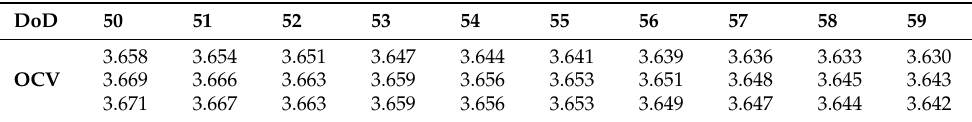
Table A6. OCV models parameters for DoD from 50% to 59%.